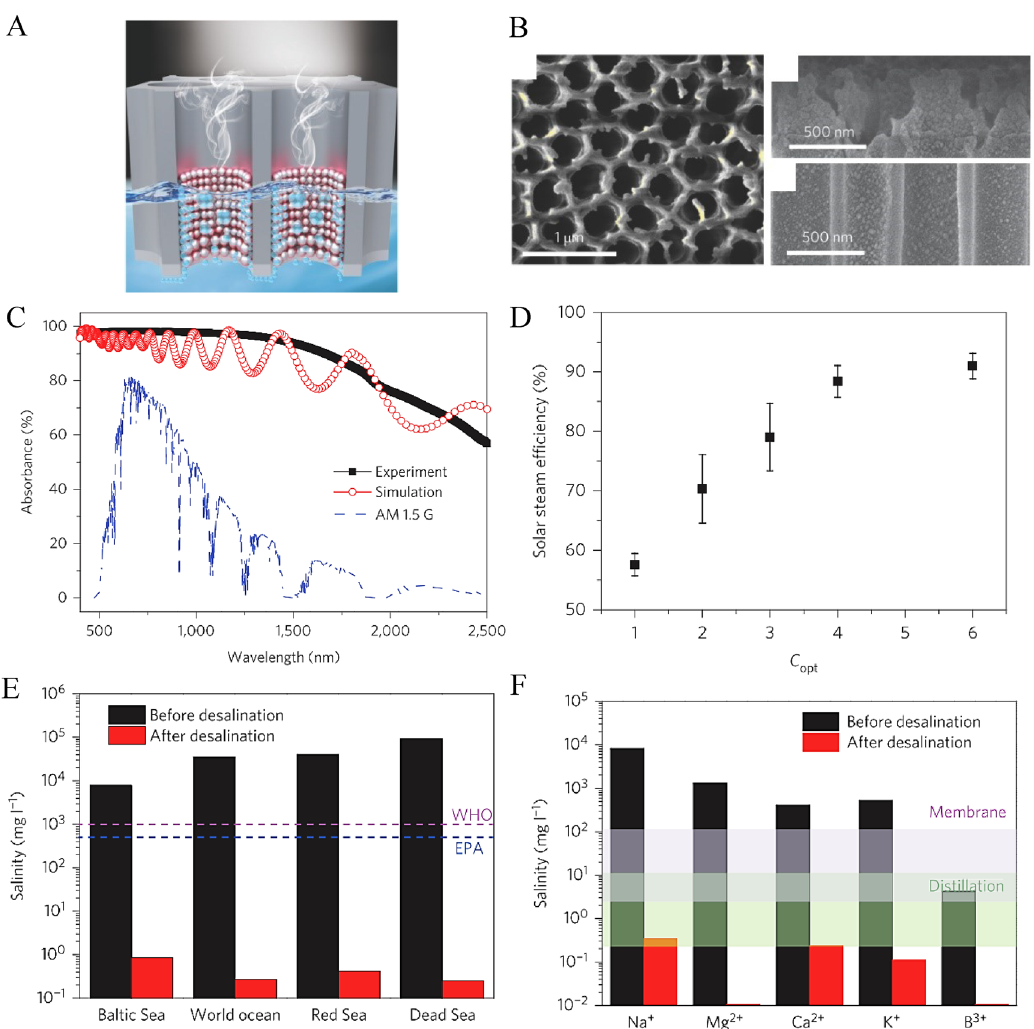
Figure 12: (A) Schematic representation and (B) top-view and cross-section SEM images of the Al NP/AAM plasmonic nanostructures. (C) Simulated and experimental absorption spectra of the Al NP/AAM plasmonic nanostructures. (D) The evaporation performance of an Al